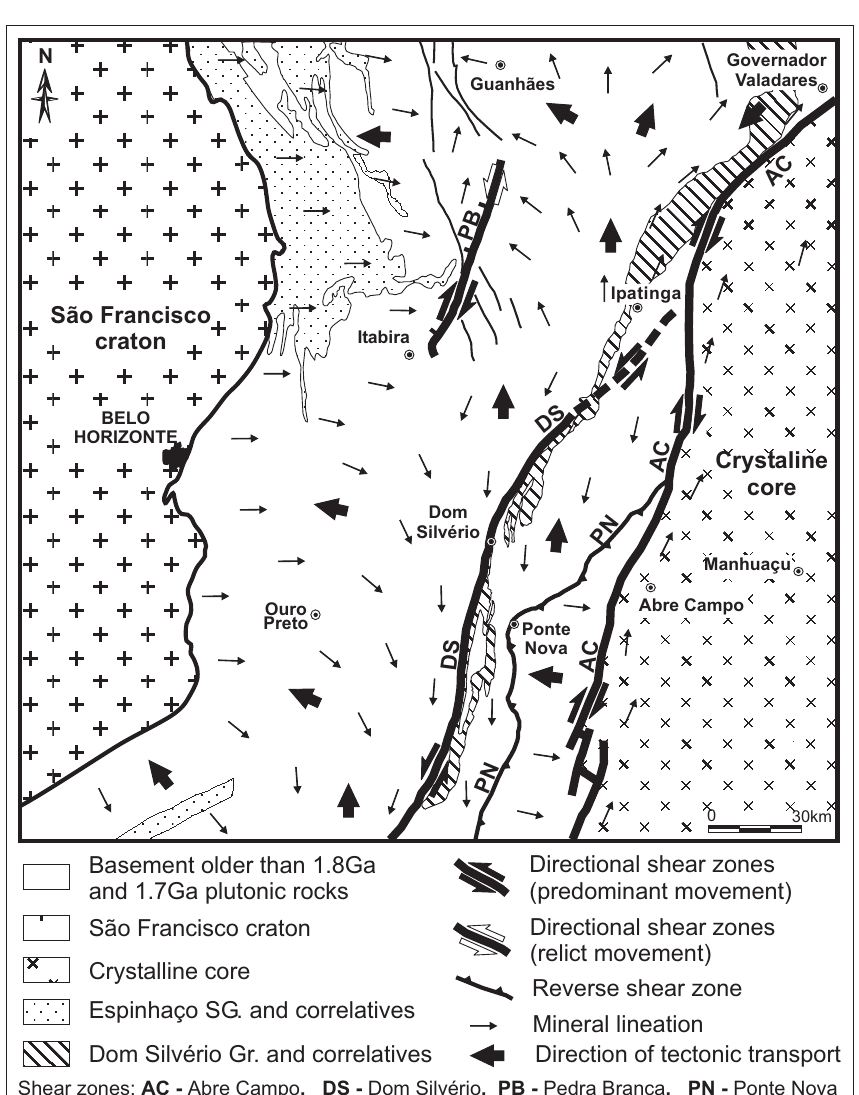
Fig. 8 – Simplified tectonic map of the southern Araçuaí